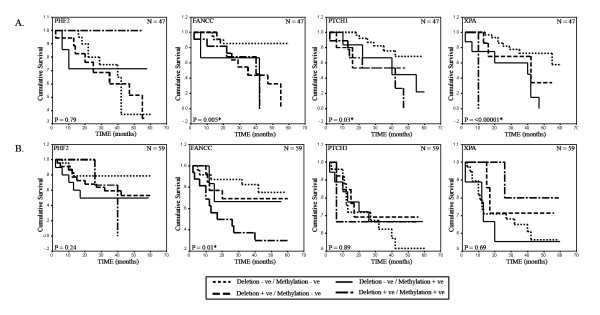
Kaplan-Meier 5-year survival probability curves with cumulative survival of BC patients by alteration status of PHF2, FANCC, PTCH1 and XPA in (A.) early-onset and (B.) late-onset BC. Survival time was defined as the time from surgery to the patient's death, known recurrence or the last time the patient was known to be alive. The log rank test was used to assess the differences in the patient survival between cases with plot for the differences in overall survival among cases with any alteration (Deletion +ve/Alteration -ve or Deletion -ve/Methylation +ve or Deletion +ve/Methylation +ve) and no alteration (Deletion -ve/Methylation -ve) of the analyzed genes. N  denotes sample size.